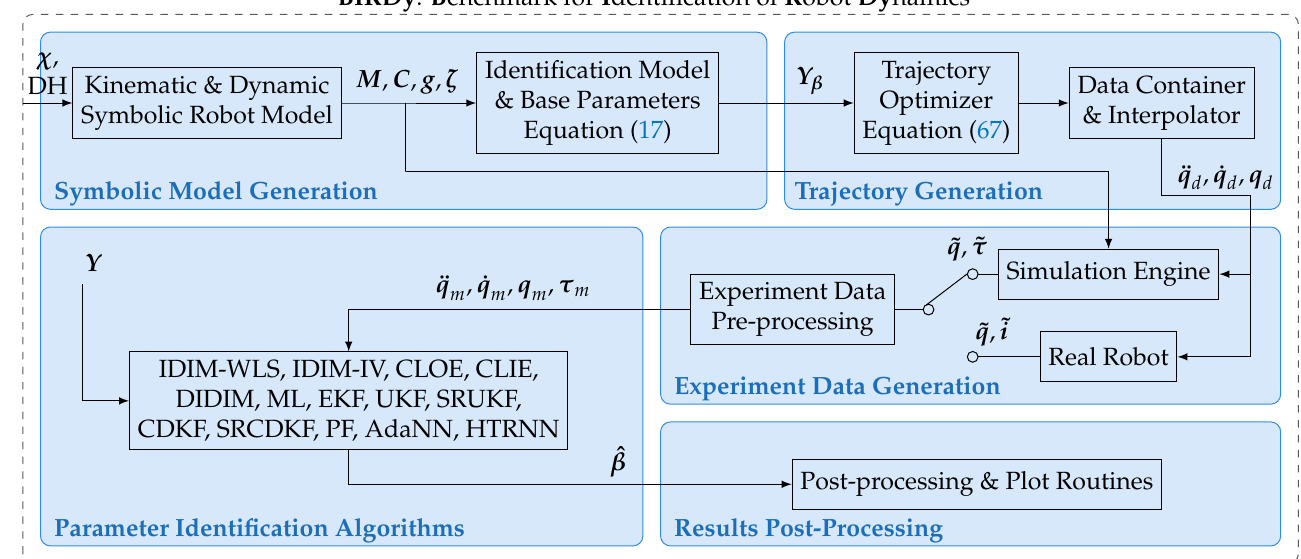
Figure 6. Block diagram of BIRDy , the Benchmark for Identification of Robot Dynamics. In this figure, ¨ q the desired trajectory data, obtained from the trajectory interpolator, ˜ q , ˜ τ , ˜ i respectively denote the noisy joint positions, torques and (in the case of a real robot) drive current measurements. The actual data ¨ q is obtained after a short pre-processing step of the raw experiment